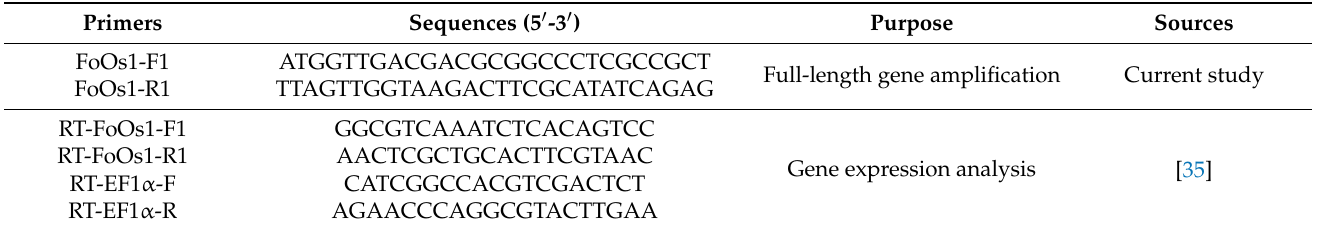
Table 2. Primers used in this study for FoOs1 full-length amplification (FLGA) and gene expression analysis